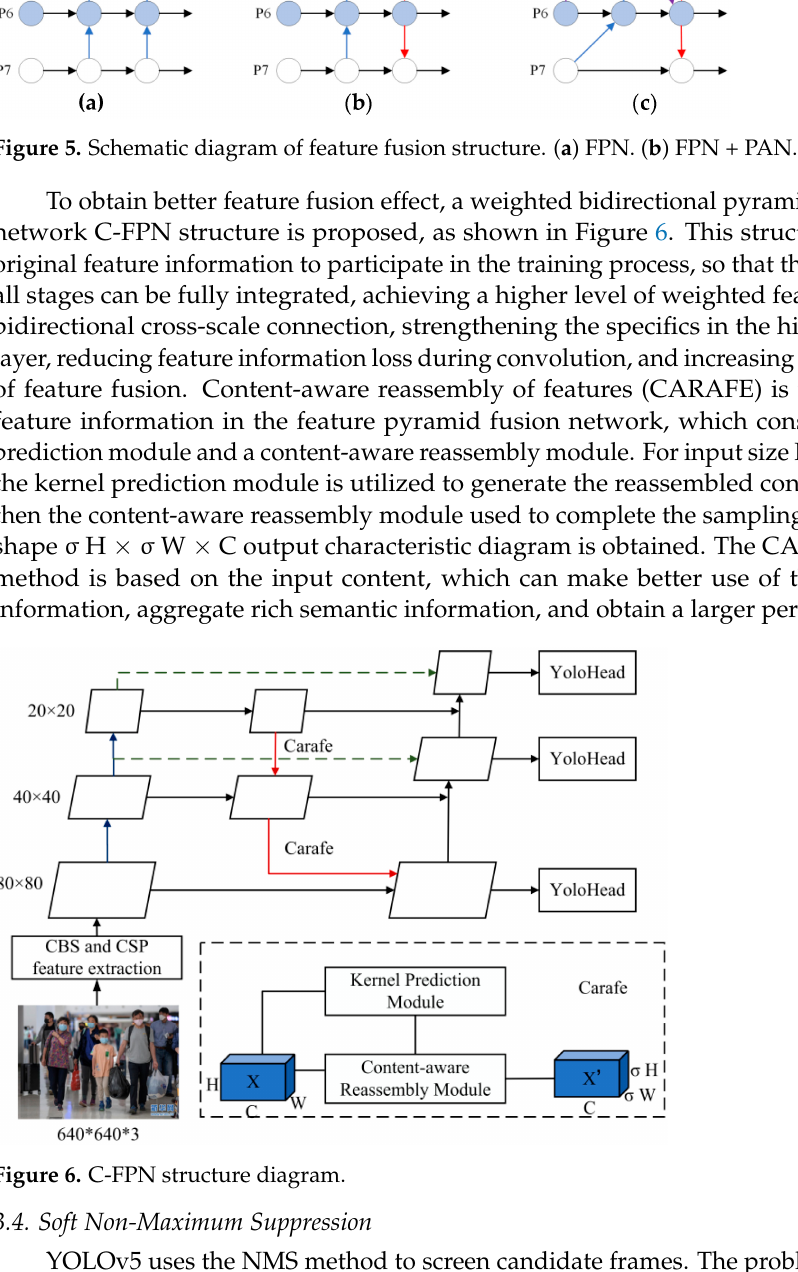
Figure 5. Schematic diagram of feature fusion structure. ( a ) FPN. ( b ) FPN + PAN. ( c ) BIFPN.